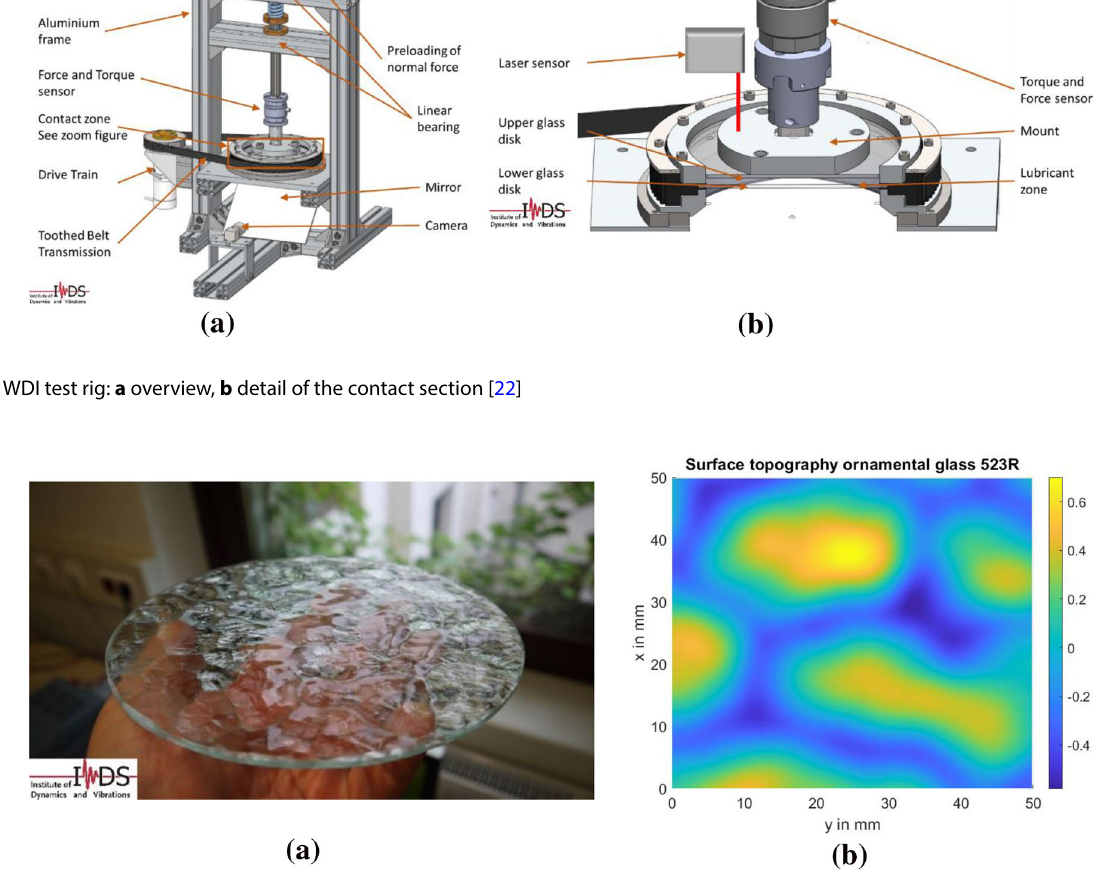
Fig. 3 a Glass panes used (ornament 523 R), b Section of the measured surface topography